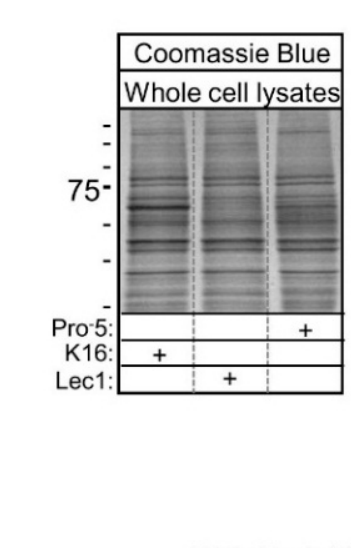
Figure 2. Lectin blots of whole cell lysates from parental and N -glycosylation mutant CHO cell lines. Pro − 5, K16, and Lec1 samples were probed with Galanthus nivalis Lectin (GNL) and Phaseolus vulgaris Leucoagglutinin (L-PHA), as indicated ( A ); SDS gels with similar levels of protein were evaluated by coomassie blue staining ( B ). Plus signs signify the cell line examined. Lines adjacent to blot and gel denote molecular weight standards in kDa: 250, 150, 100, 75, 50, 37, 25 and 20 from top to bottom.